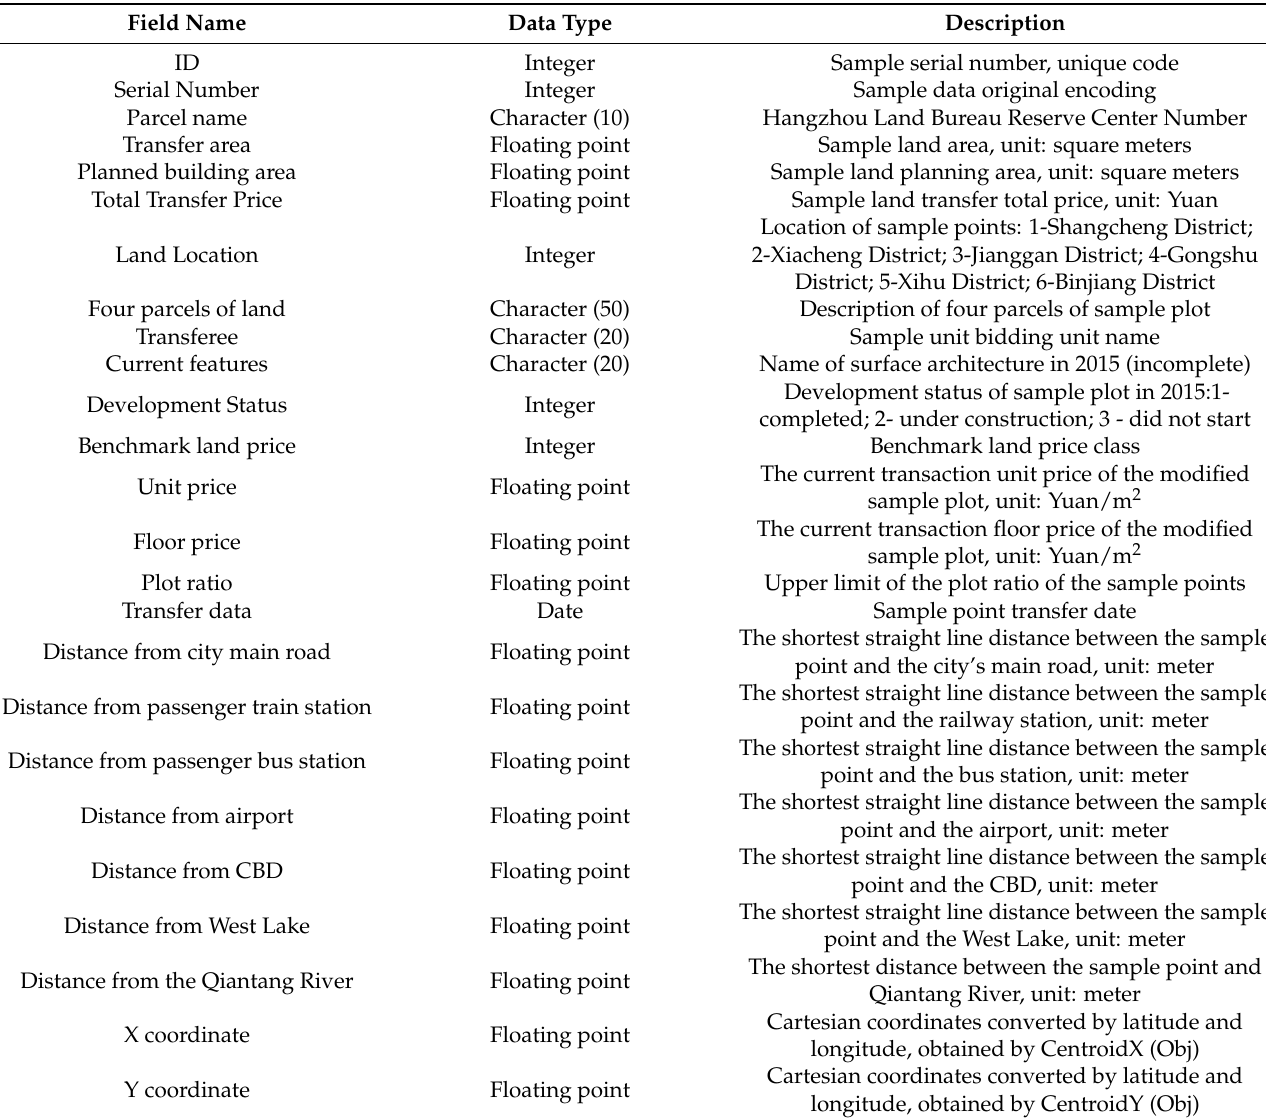
Table 3. Design of the corresponding attribute field of the graph